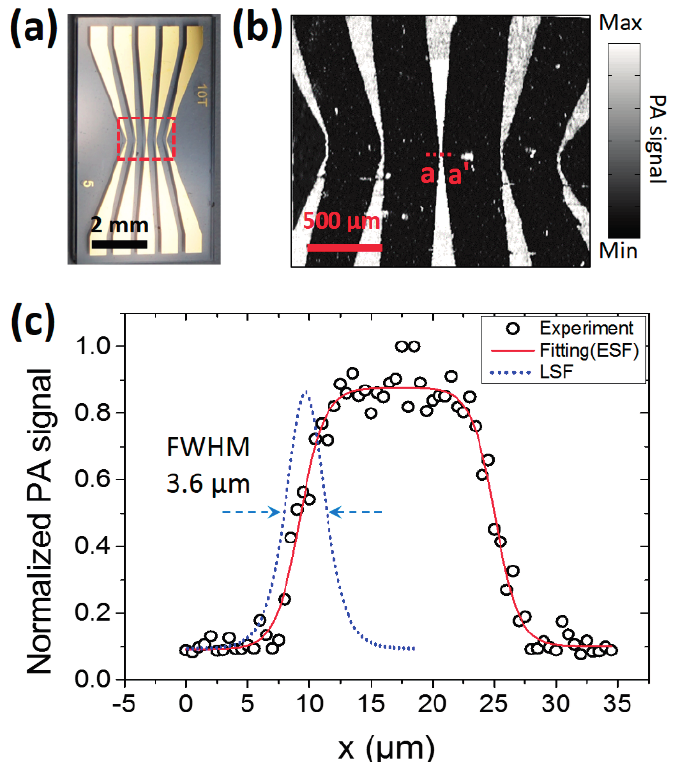
Figure 6. In vitro PA imaging of gold micro-patterns using the 2A-PDMS-WP-OR-PAM. ( a ) Photograph of gold micro-patterns; ( b ) PA maximum amplitude projection image of the red boxed region of (a); ( c ) PA amplitude profile across the a-a ′ line of (b) and fitted edge spread function (ESF) and line spread function (LSF). Full width at half maximum (FWHM) in the plot means a lateral resolution of the